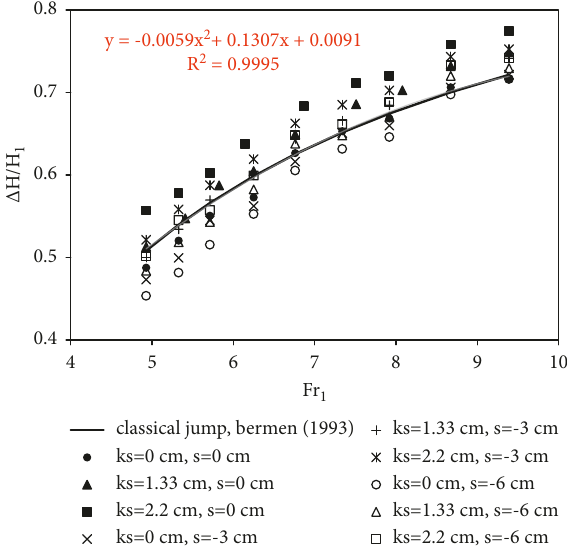
Figure 8: Variation of Δ H / H